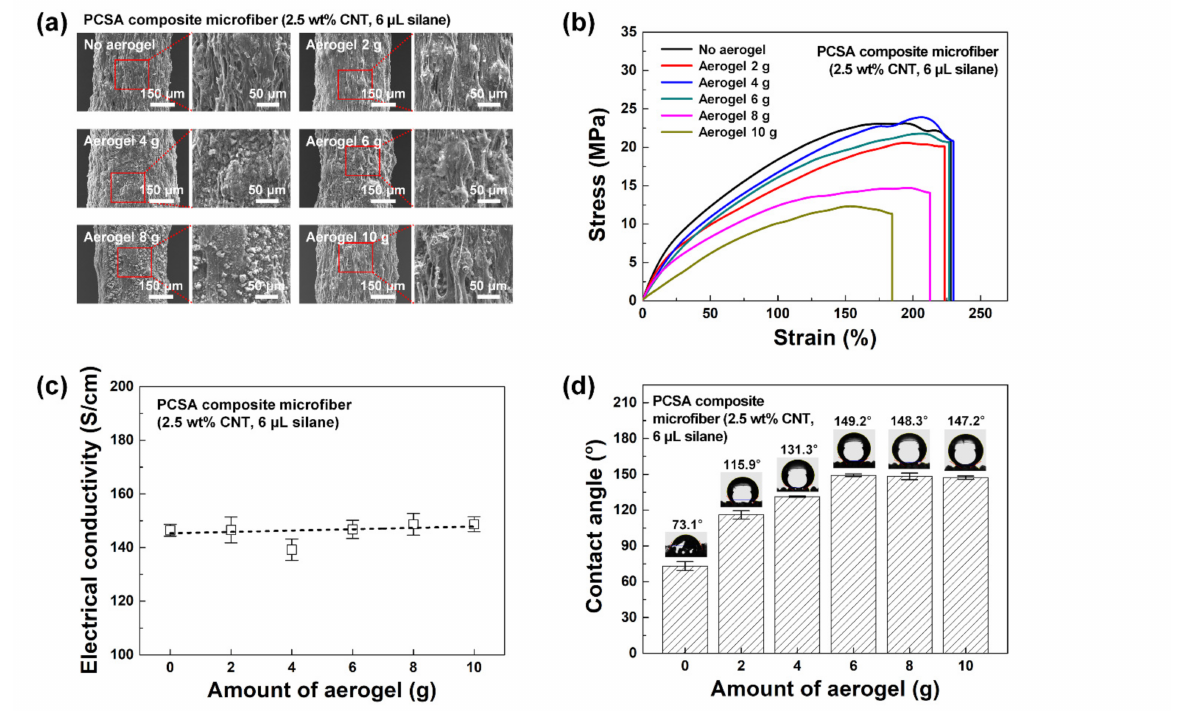
Figure 4. ( a ) FESEM images, ( b ) stress–strain curves, ( c ) electrical conductivities, and ( d ) wettabilities of PCSA composite microfibers (2.5 wt% CNT, 6 µ L silane) with di ff erent amounts of aerogel (0, 2, 4, 6, 8, and 10 g) added to the coagulation bath during